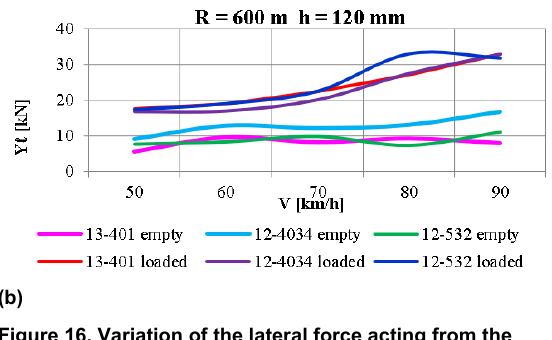
Figure 16. Variation of the lateral force acting from the track to the wheel with the motion speed: (a) R=350 m curve; (b) R=600 m curve